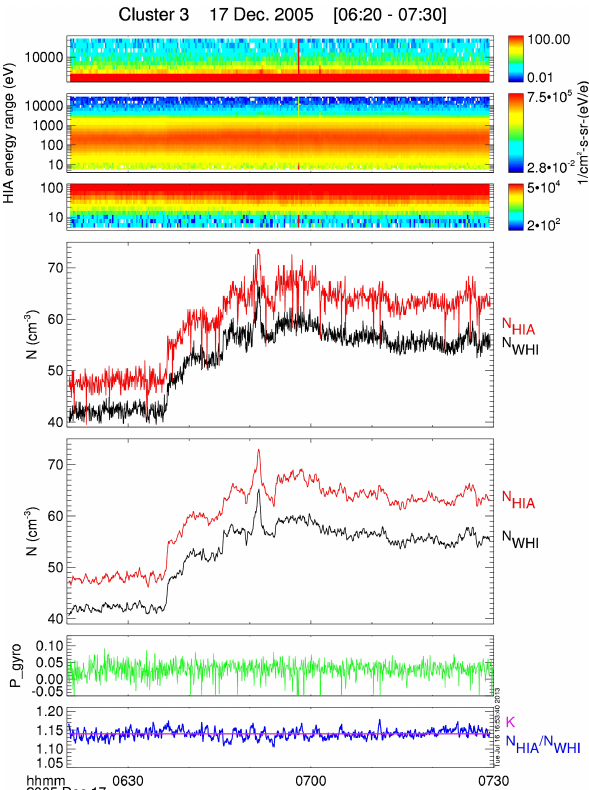
Fig. 3. Calibration of HIA’s HS section. The top panels show ion energy spectrograms in three ranges, i.e., above 2keV, the entire HIA energy range, and below 100eV. The next panel presents HIA (red) and WHISPER (black) raw density data while in the fifth panel, the data from the two instruments are processed. The sixth panel presents the deviation in gyrotropy, based on the relative dif- ferences between the perpendicular pressure components. The bot- tom panel shows the ratio between the two densities (blue) and its average value K (magenta straight line). More explanations are pro- vided in the